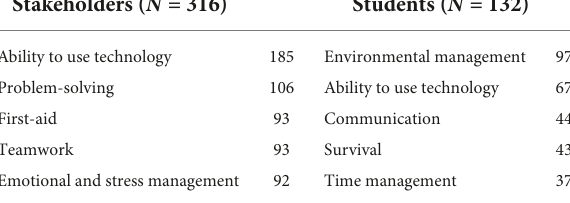
TABLE 3 Comparing stakeholder’s and student’s perspectives from